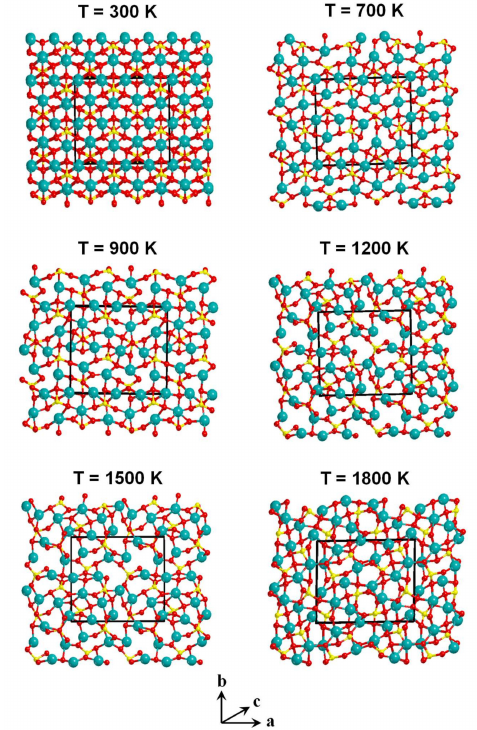
Figure 2. Structures obtained by classical molecular dynamics (MD) simulations. For all simulations, the initial guess structure was the crystal system. It was initially heated up to the given temperature and then submitted to the MD simulations at the (N,V,T) ensemble. Unit cells are shown in black. Mg atoms in green, Si atoms in yellow and O atoms in